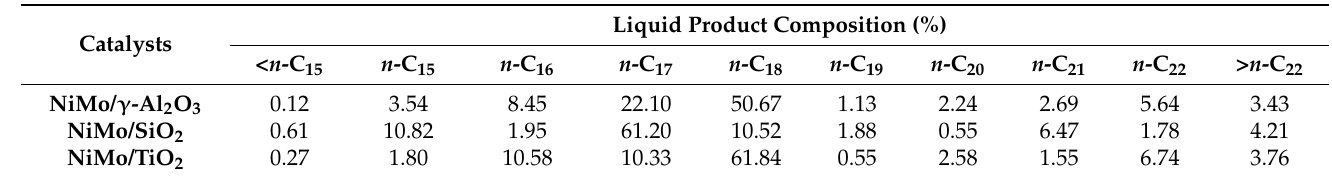
Table 4. Composition of the liquid product from the catalytic hydrotreating of Pongamia pinnata oil over the sulfided NiMo catalysts.